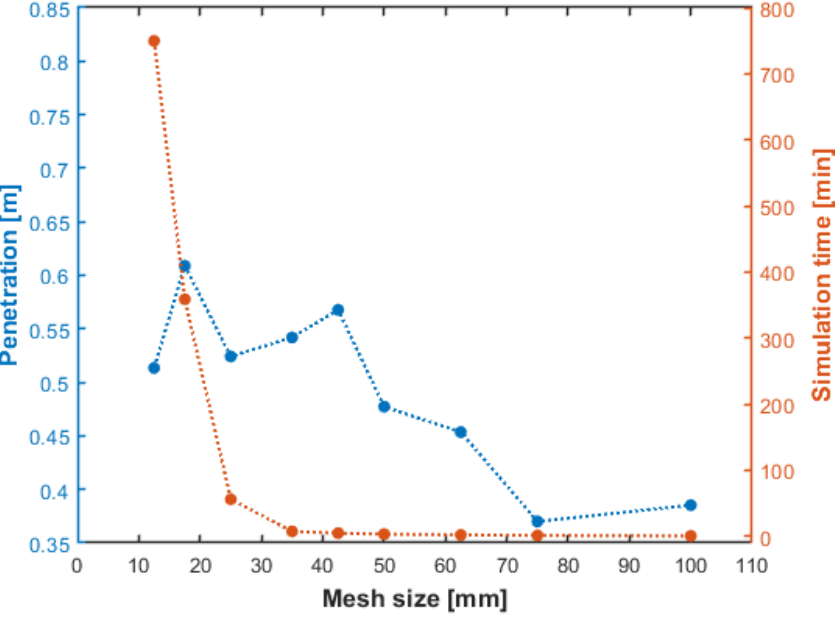
Figure 3. Mesh convergence study results.